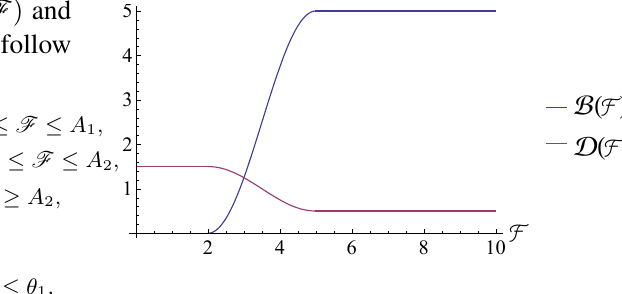
Fig. 7. The generic birth and death rate